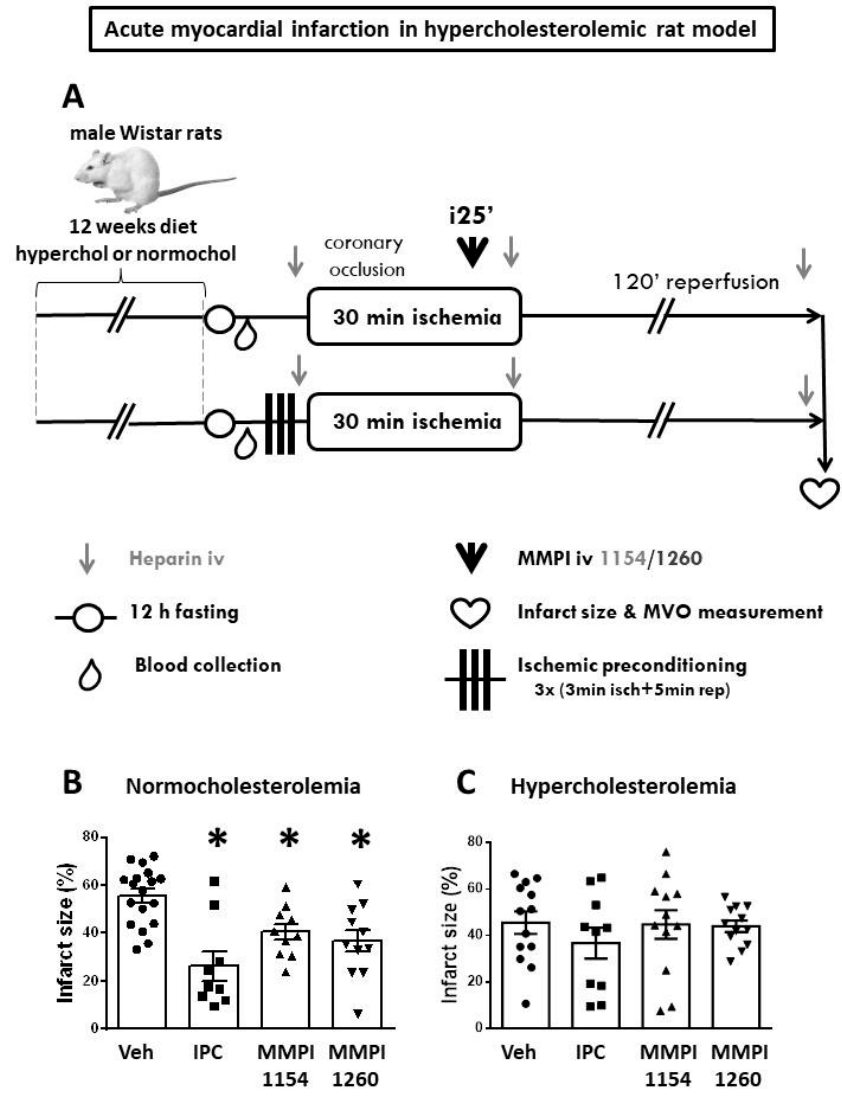
Figure 4. Hypercholesterolemic model. ( A ) In vivo experimental protocol of acute myocardial infarction in hypercholesterolemic rat model. The effects of ischemic preconditioning and MMP inhibitors on infarct size in normocholesterolemic ( B ) and hypercholesterolemic ( C ) rats subjected to in vivo 30-min coronary occlusion followed by 120-min reperfusion. Veh: dimethyl sulfoxide, IPC: ischemic preconditioning. One-way ANOVA followed by Fisher’s LSD post-hoc test, n = 12–14, data are expressed as means ± SEM, * p < 0.05.